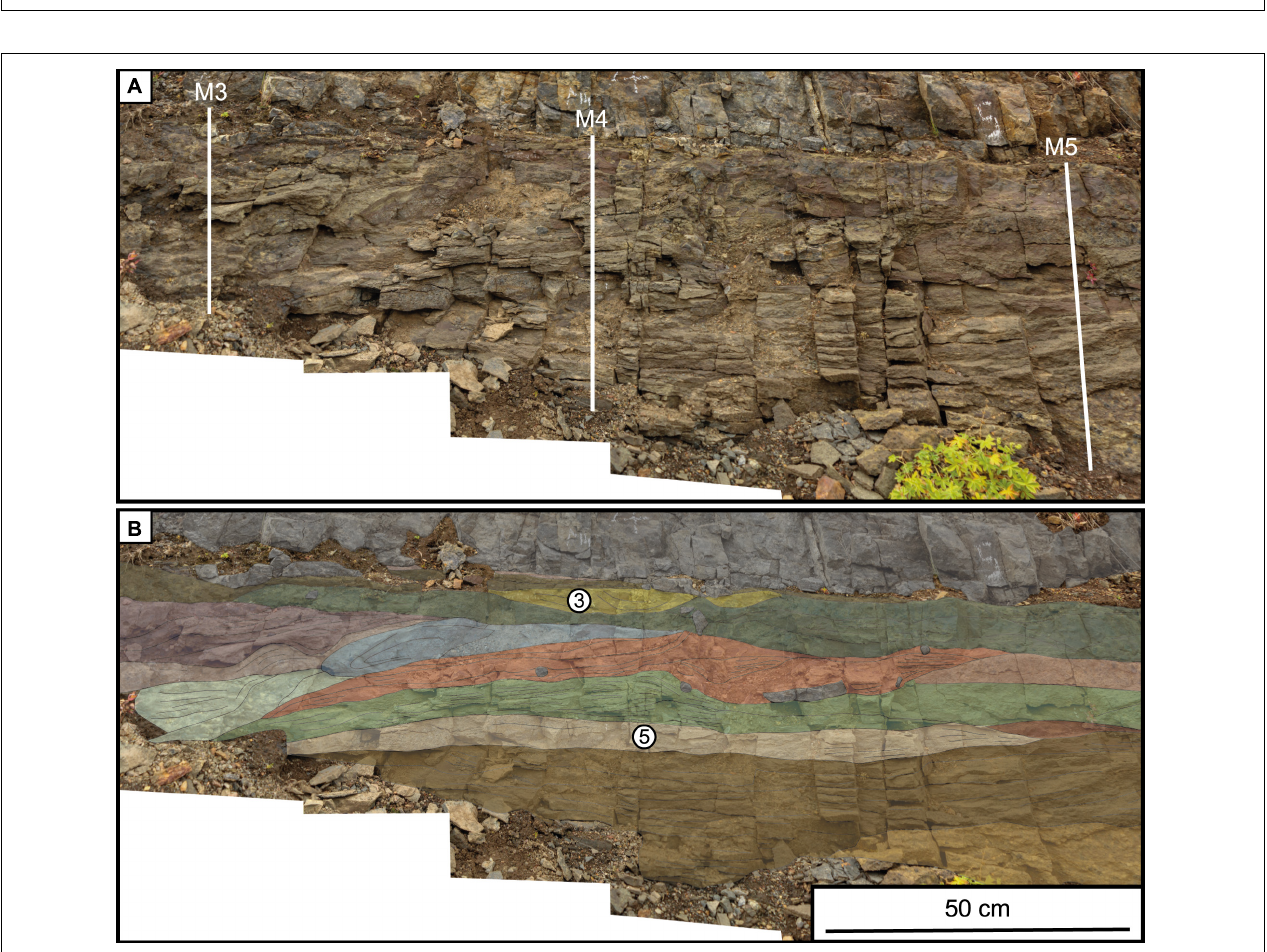
FIGURE 4 | Photograph (A) and interpretation (B) showing a closer view of the tuffisite, which has a clear but complex internal structure consisting of many units. M3, M4, and M5 labelled on (A) give the location of the graphic logs shown in Figure 5 . Labels 3 and 5 mark examples of Structure 3 (channels) and Structure 5 (fine rimmed sub-horizontal lenses, interpreted as finger-shaped injections in section “Structure 5: Finger-Shaped Injections”). Note how units are dipping toward the S.